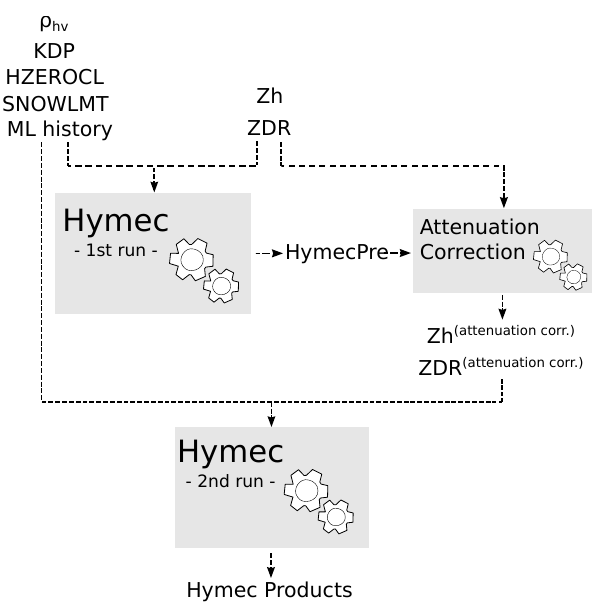
Figure 2. The two-step Hymec algorithm run. The first Hymec run provides the attenuation-corrected Z h and ZDR. The dashed lines denote the data paths of the algorithm.